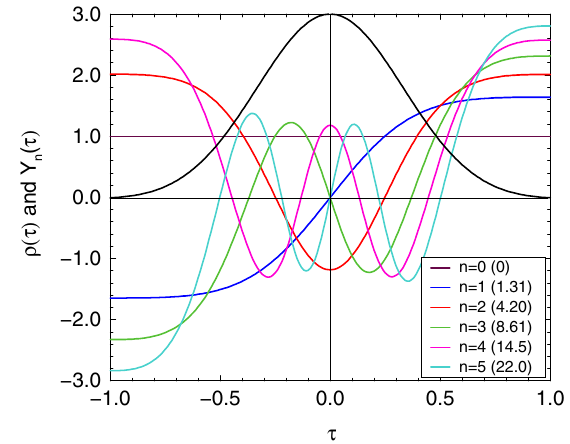
of the truncated n